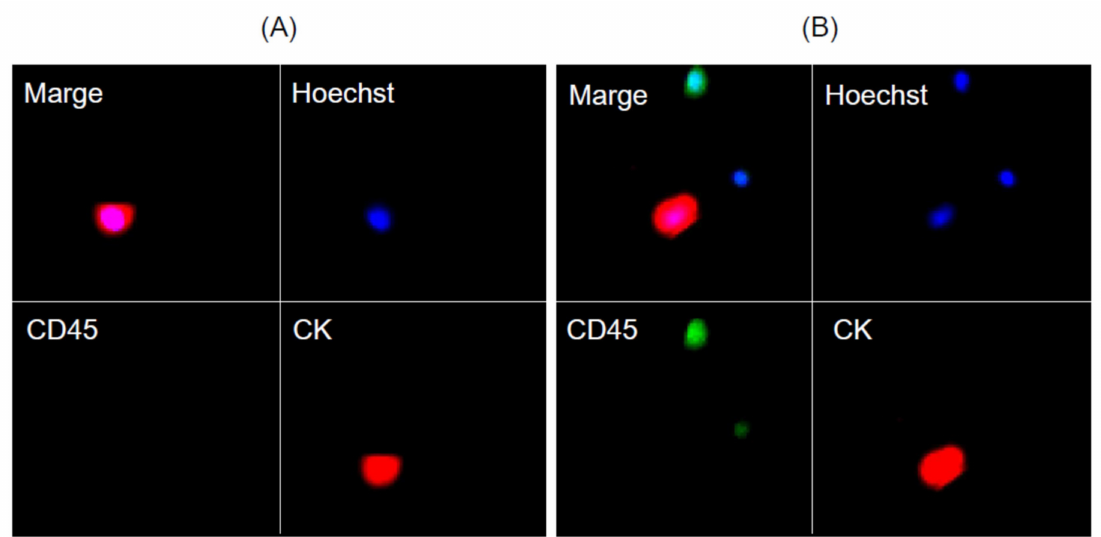
Figure 4. Detection of tumor cells (ACC-MESO-4 cells spiked in blood ( A ) and circulating tumor cells in patients with malignant pleural mesothelioma ( B )) captured on the CTC-chip coated with an anti-podoplanin antibody (clone